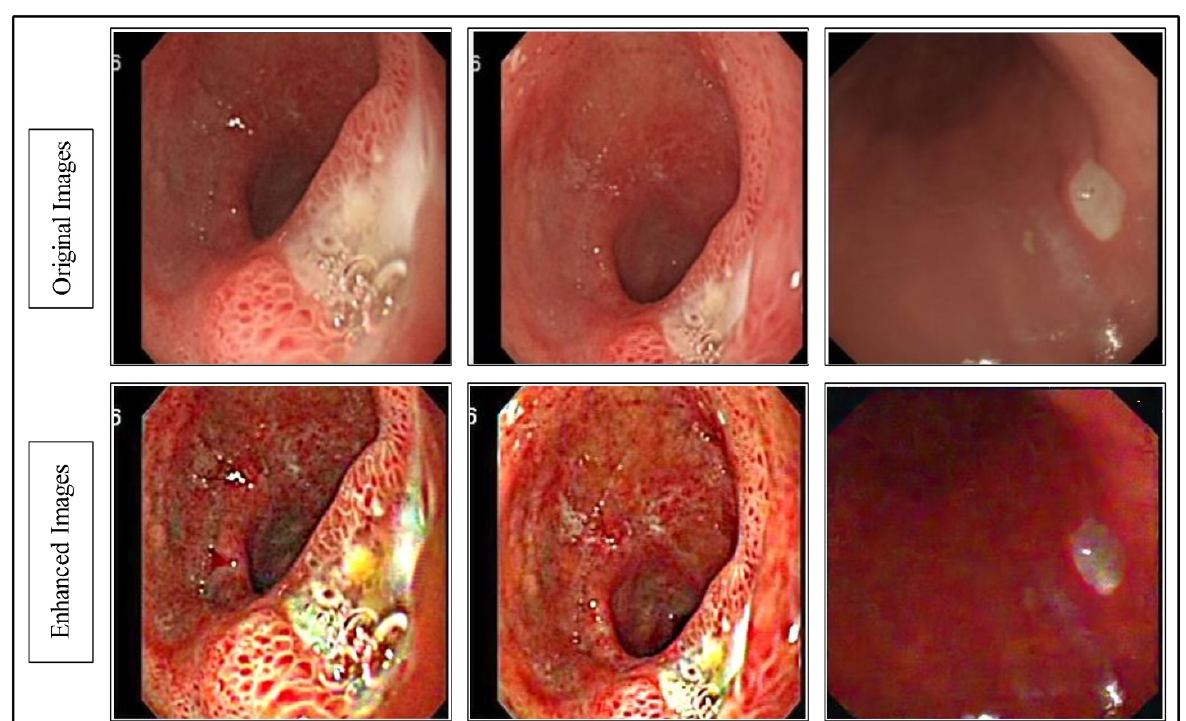
Figure 2. Proposed hybrid contrast enhancement image effects.